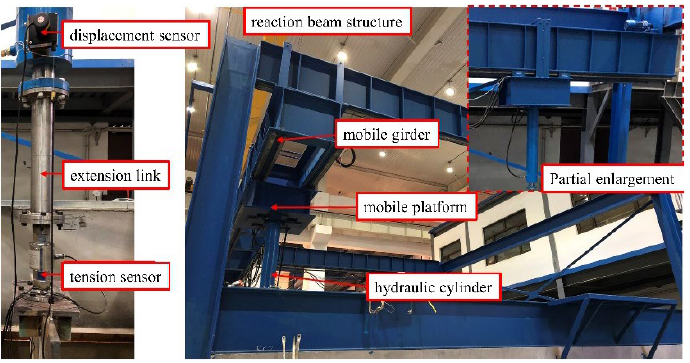
Figure 4. Loading and measurement system.